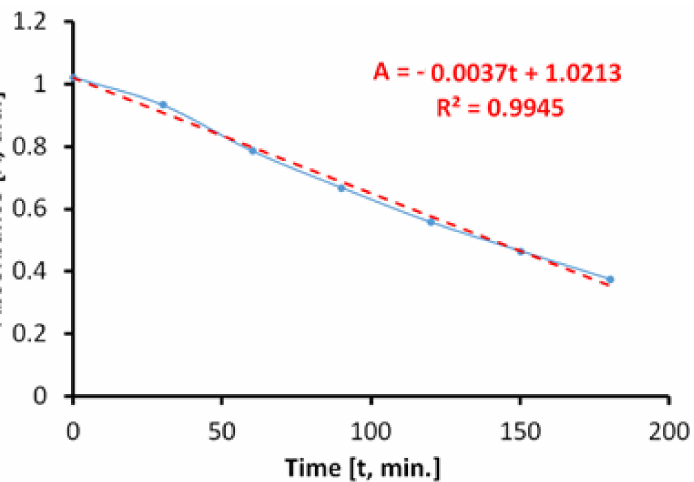
Figure 14. Time variation of MB solution absorbance by irradiating with arc-xenon light in the presence of the photocatalytic paint.